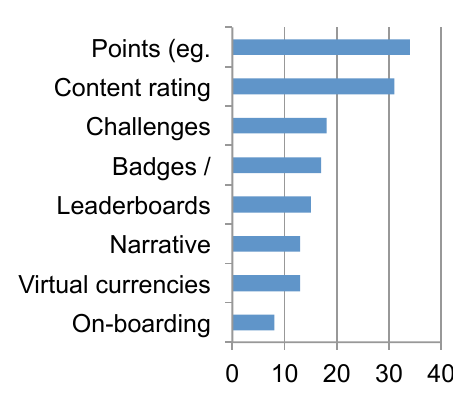
Fig. 5 SEGAN survey: gamification elements ranked by perceived motivation